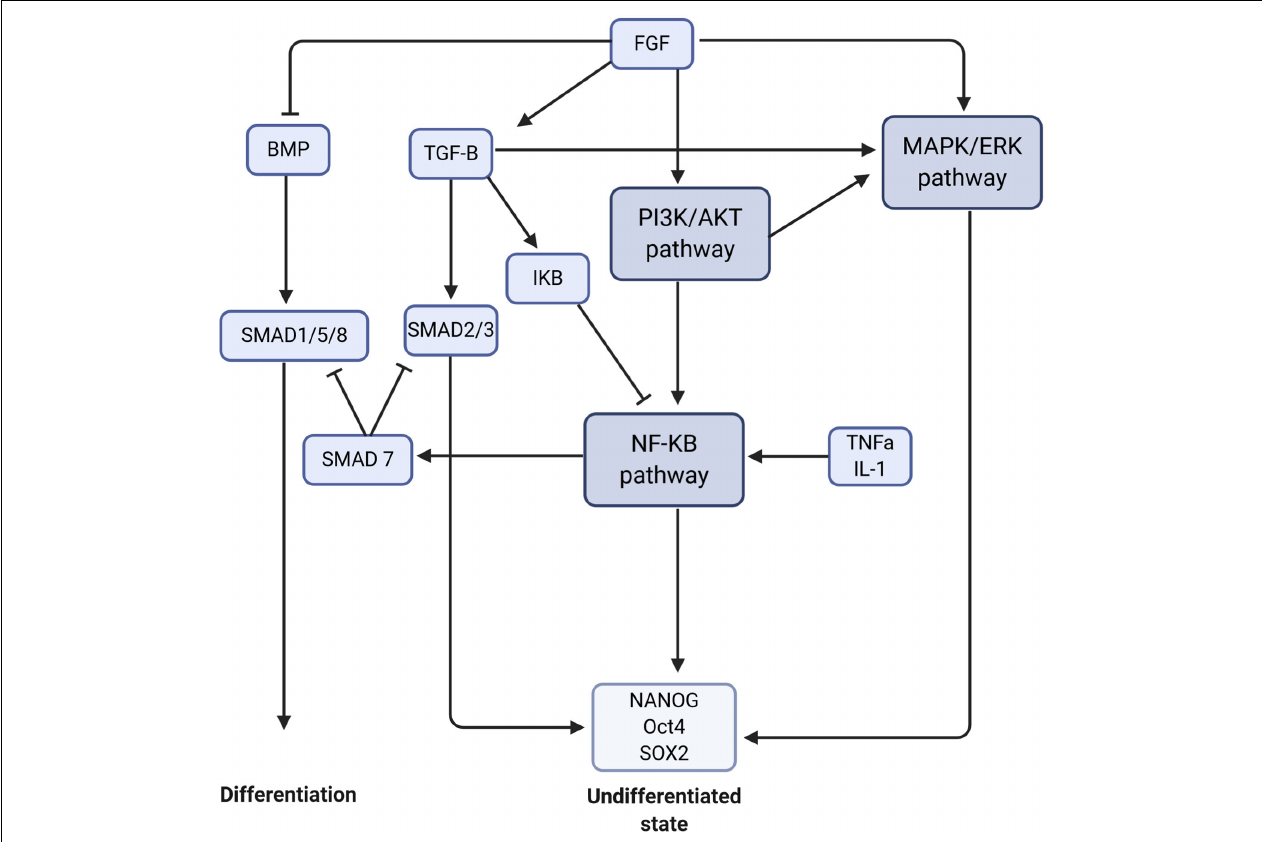
FIGURE 2 | Crosstalk between signaling pathways to maintain stem cells in an undifferentiated state or to trigger the differentiation. The signaling pathways are in dark purple, the molecules/proteins are represented in blue, and the transcription factors in light blue. The arrows mean activation and the flat arrows inhibition.